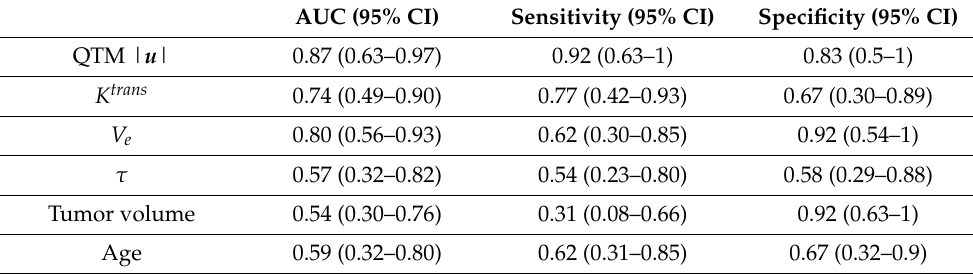
Table 2. ROC analysis for low-risk and high-risk LSF